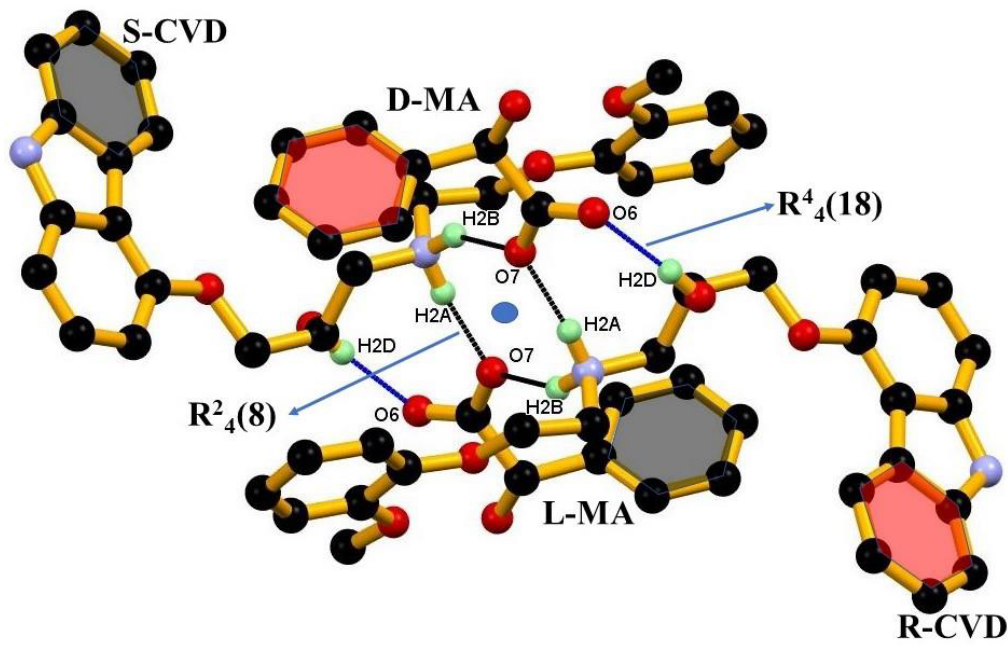
Figure 3. Dimeric units of protonated CVD, bridged by corresponding MA anions in the molecular salt by N2–H2A∙∙∙O7, N2–H2B∙∙∙O7 strong hydrogen bonds, which result in the R 24 (8) ring motif (inner ring), and by O2–H2D∙∙∙O6, N2–H2B∙∙∙O7 strong hydrogen bonds, which result in the R 44 (18) ring motif (outer ring) in the crystal structure of the salt. Blue dot indicates the inversion center and dotted lines indicate the non-covalent interaction (hydrogen atoms not involved in the hydrogen bonding were removed for clarity).